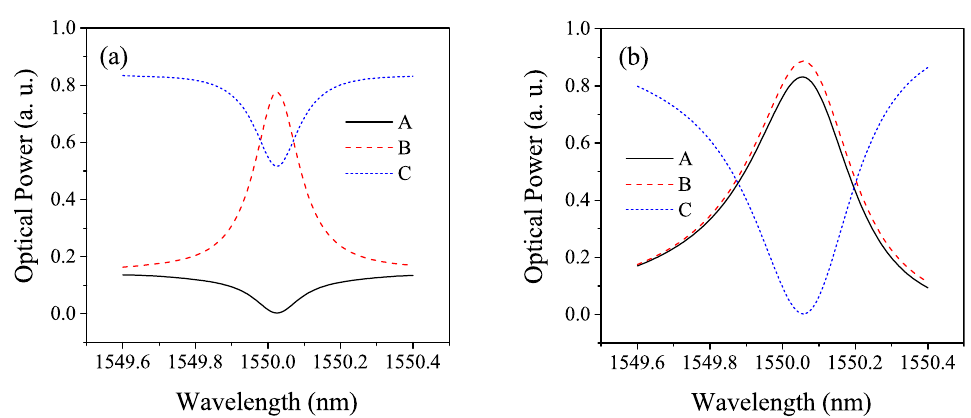
Figure 2. Optical spectra of the micro-ring resonator. ( a ) On resonance in ring 3 and ( b ) off resonance by adding a refractive index tuning of Δ n = 4 × 10 − 4